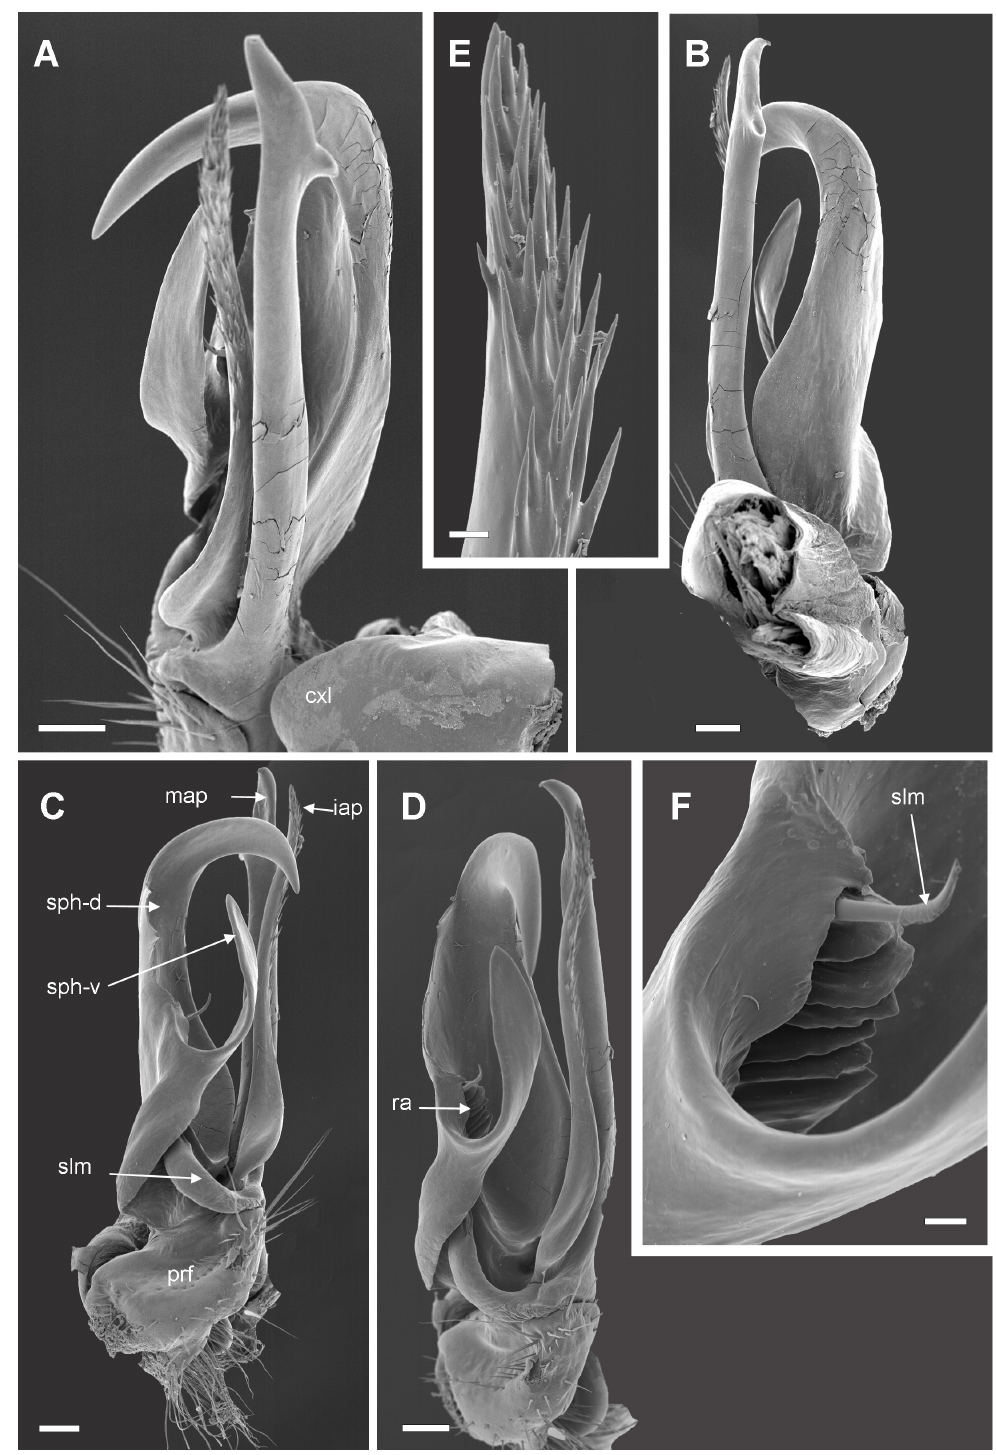
Fig. 13. Eviulisoma cetafi sp. nov., paratype, right gonopod. A . Mesal view. B . Meso-dorsal view. C . Latero-ventral view. D . Ventral view. E . Spiny tip of iap. F . Ridged area of solenophore with tip of solenomere sticking out. Abbreviations: cxl = coxal lobe; iap = intermediate acropodital process; map = mesal acropodital process; prf = prefemoral part; ra = ridged area of solenomere; slm = solenomere; sph-d , sph-i , sph-v = dorsal, intermediate and ventral lobes of solenophore. Scale bars: A–D = 0.1 mm; E = 0.01 mm; F = 0.02